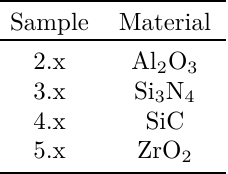
Table 1. Materials of individual series of samples.